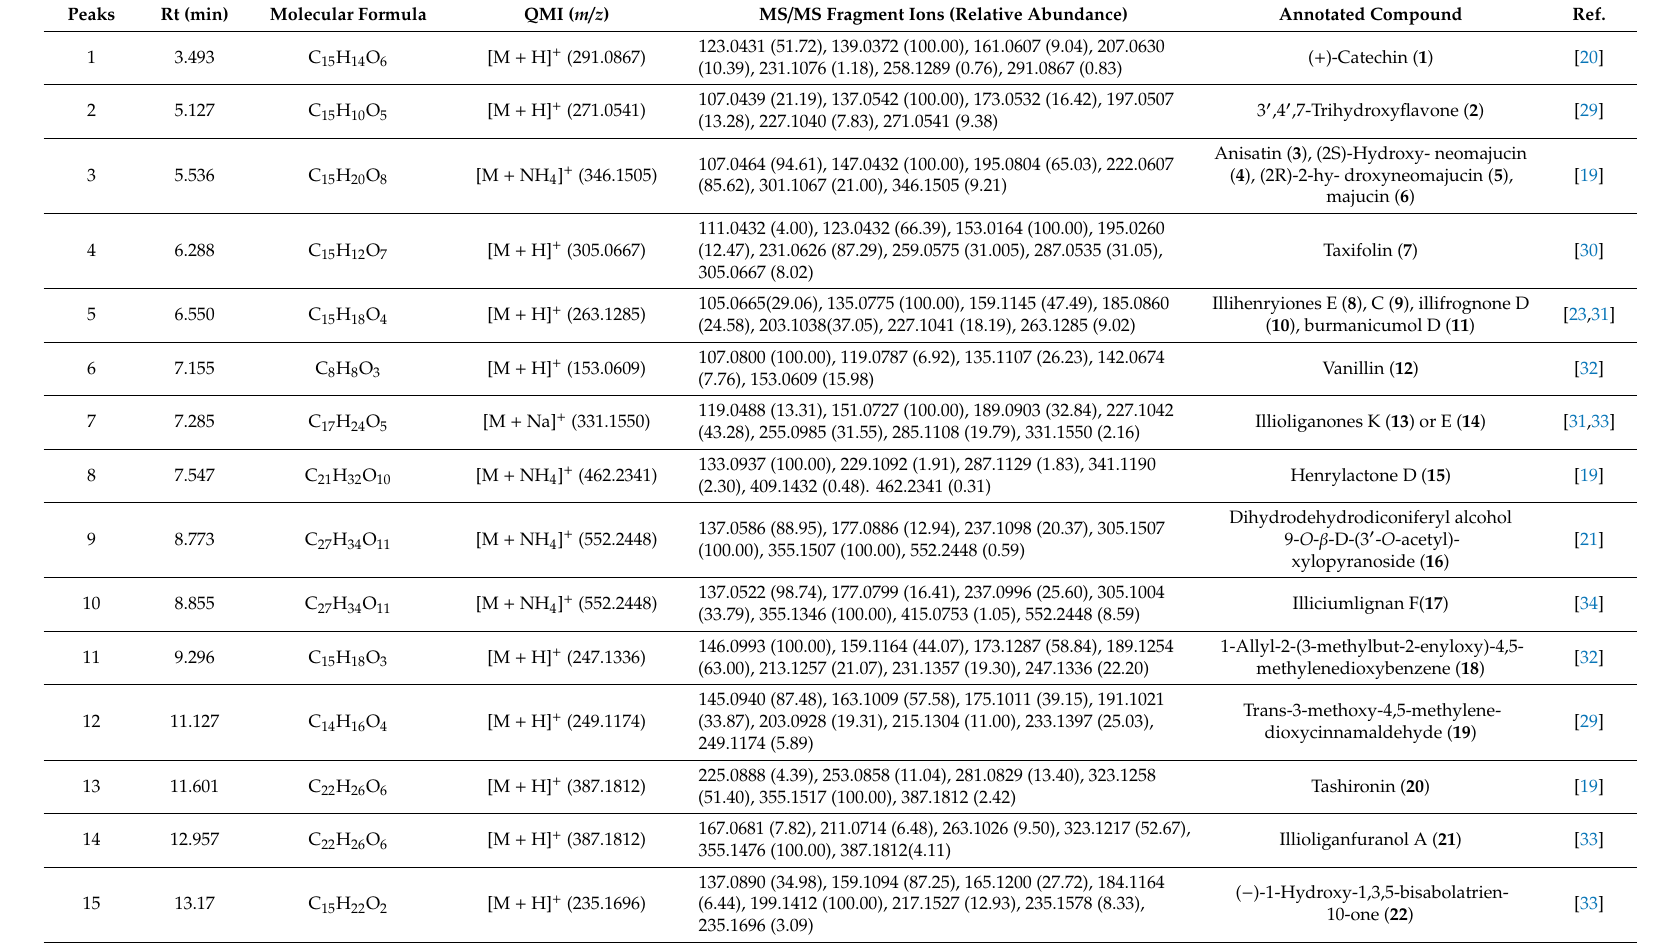
Table 1. MS data and annotated compounds in ethanol extract of I. henryi (EEIH) by HPLC–QTOF–MS /